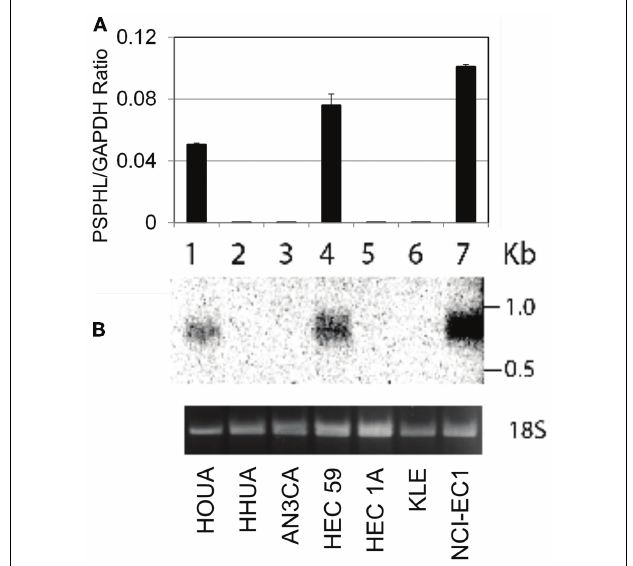
FIGURE 6 | (A) Expression levels of PSPHL in uterus cancer cell lines using quantitative PCR. (B) Northern blot analysis using PSPHL specific probes, (1) HOUA (2) HHUA (3) AN3CA (4) HEC 59 (5) HEC 1A (6) KLE (7) NCI-EC1. Ethidium Bromide stain of the 18s subunit for loading control.